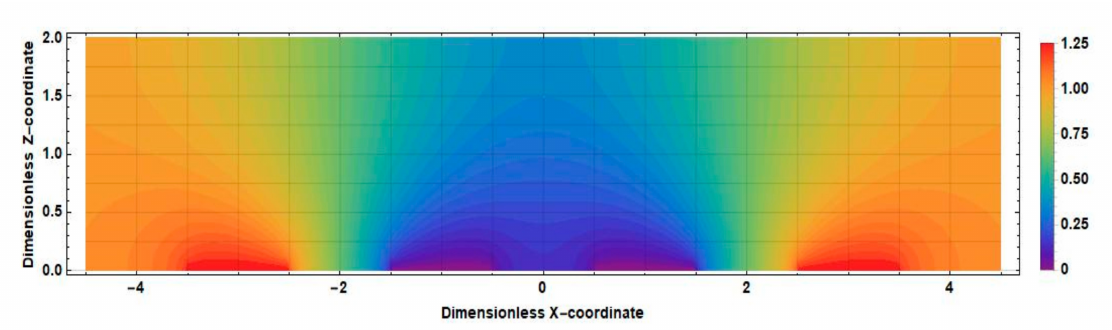
Figure 12. The distribution of the stationary concentration of the active component of an electrolyte solution in an electrochemical cell at 2˜ l c = 0.